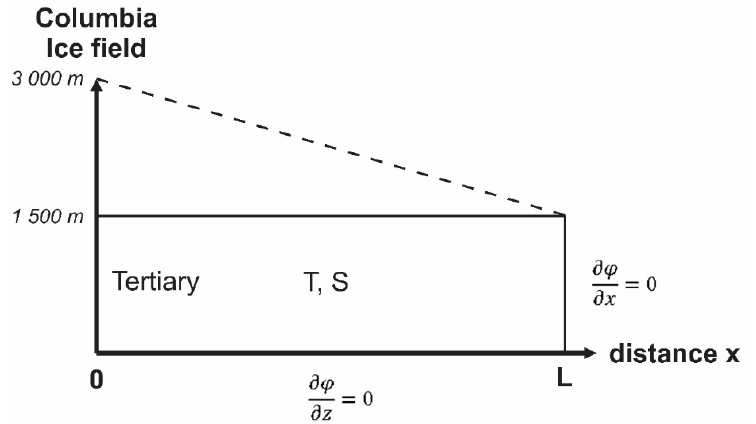
Figure 20. Conceptual model with initial and boundary conditions for the Tertiary and top Cretaceous above Lea Park, adopted for the analytical solution of response time using the diffusivity concept and time constant.